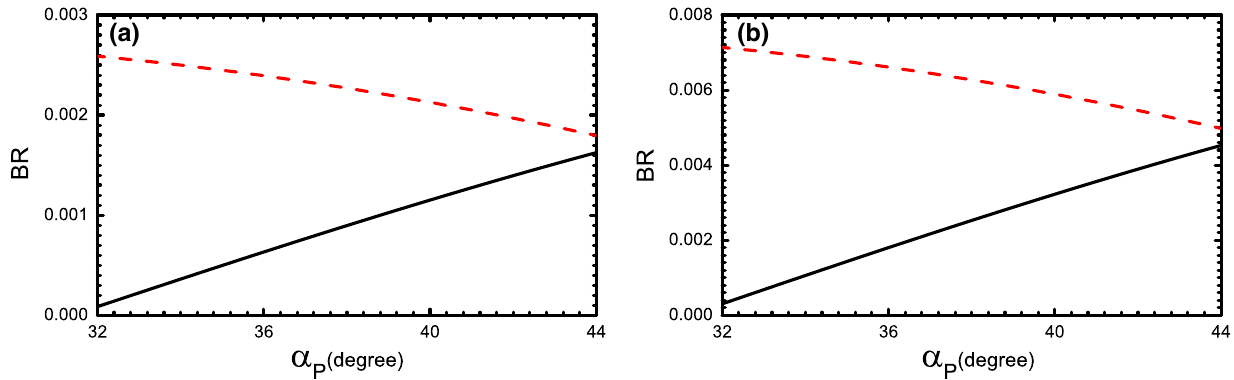
Fig. 3 (Color online). a The branching ratios of h c → γη ( solid line ) and h c → γη (cid:3) ( dashed line ) in terms of the η – η (cid:3) mixing angle with α = 0 . 3. b The branching ratios of h c → γη ( solid line ) and h c → γη (cid:3) ( dashed line ) in terms of the η – η (cid:3) mixing angle with α = 0 . 5